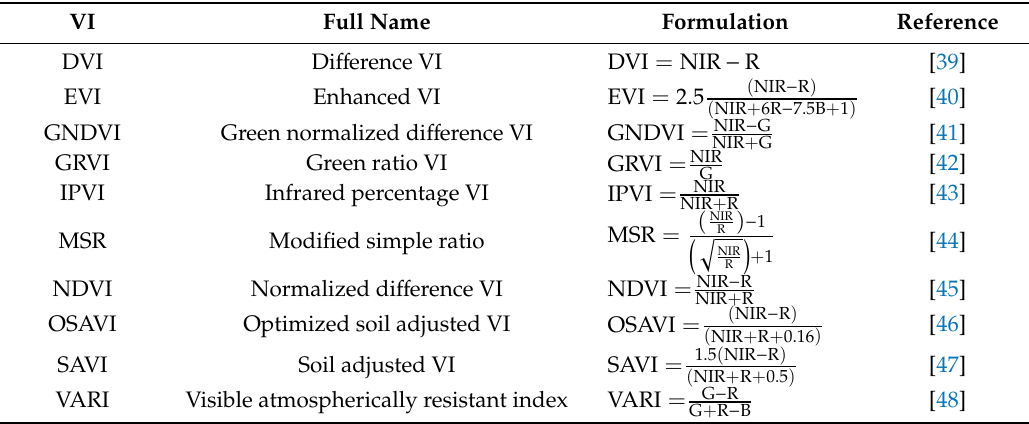
Table 3. Summary of vegetation index (VI) listed in this study. R, G, B, and NIR represent the reflectance of the satellite in the red, green, blue, and near infrared bands,